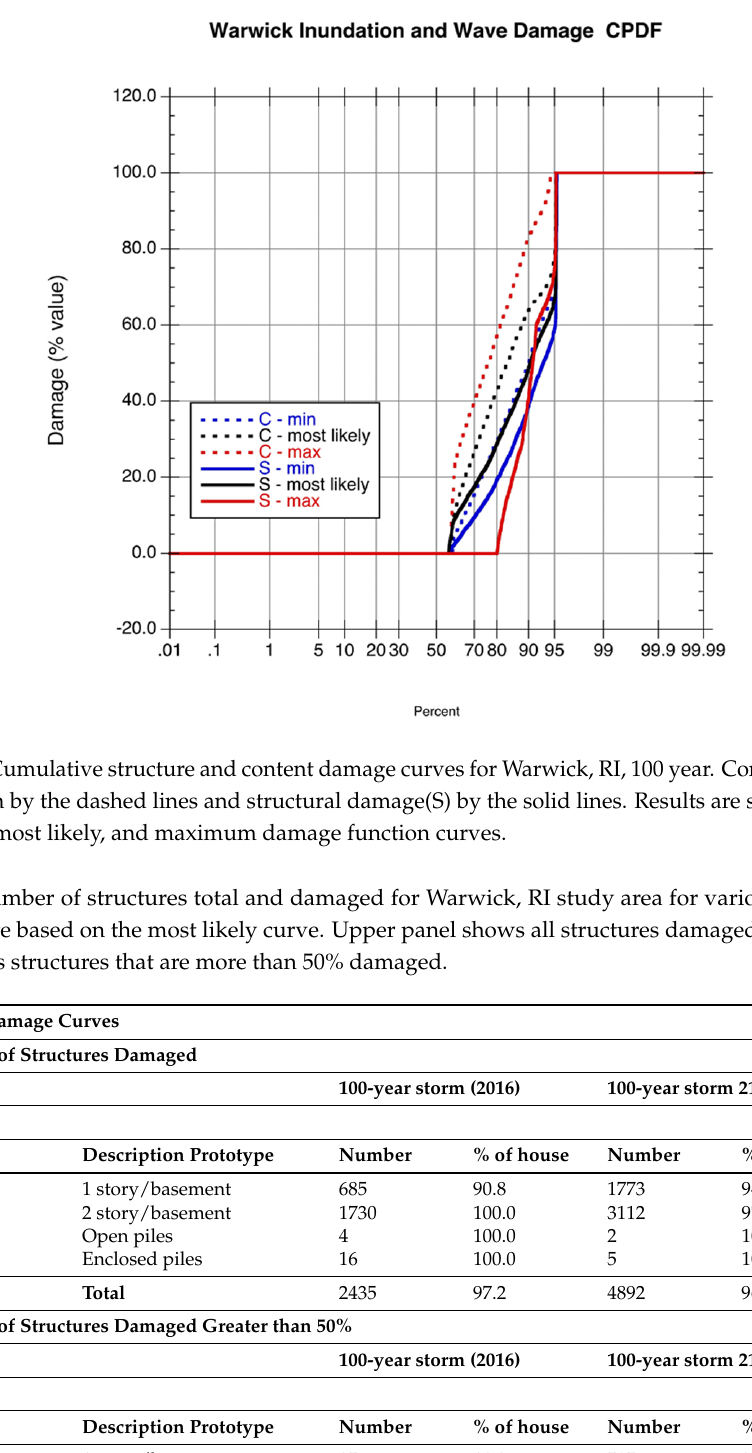
Figure 17. Percent damage by structure for Warwick, RI for 100 year event.